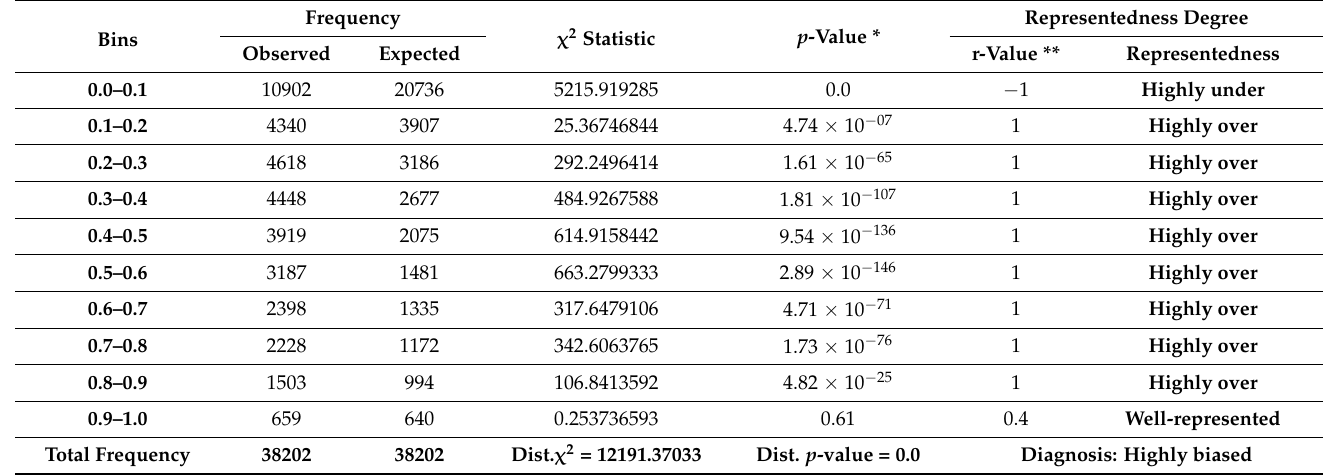
Table 5. Pearson’s χ 2 test results with market accessibility variable.